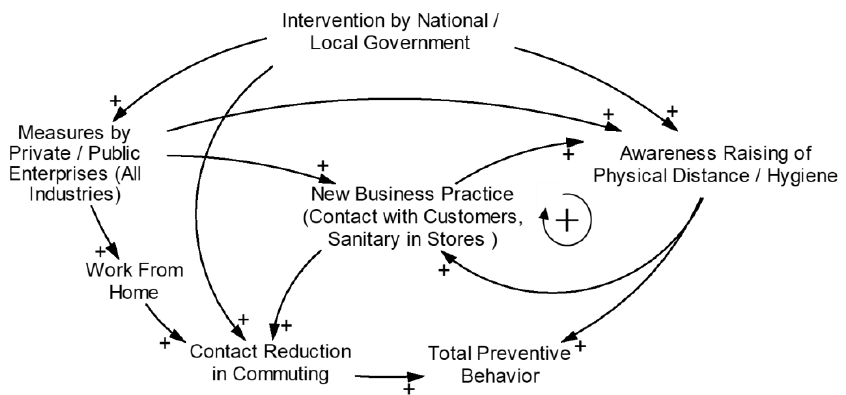
Figure 6. Causal loop diagram for societal factors related to new infectious diseases.